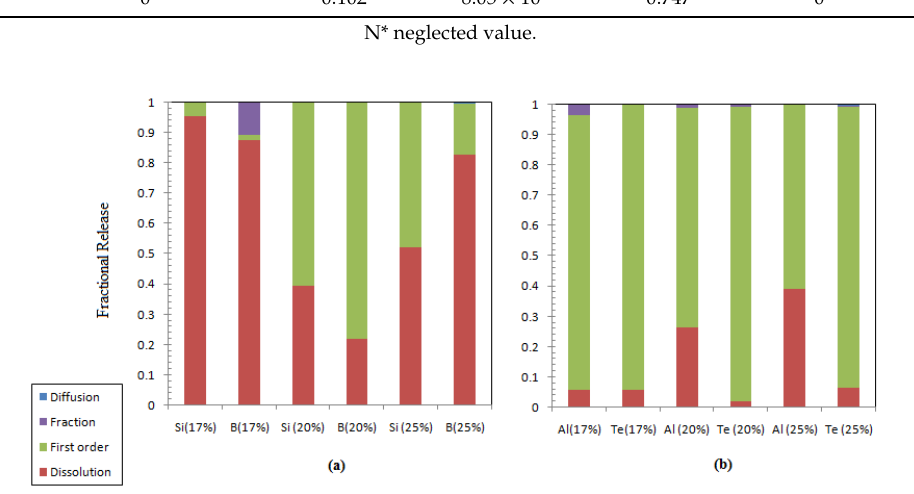
Figure 7. Contribution of different leaching processes to the fractional release: ( a ) structural element; ( b ) post-transition and other metalloid elements.